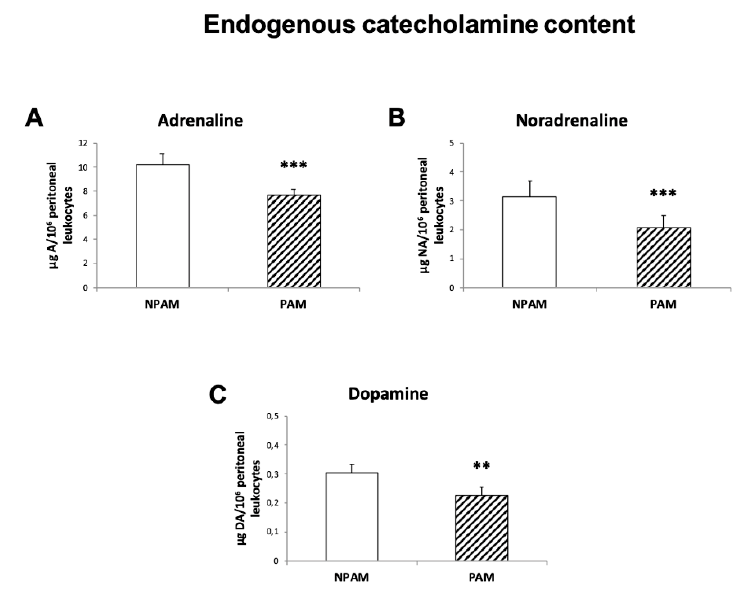
Figure 8. Endogenous catecholamine content ( µ g/10 6 peritoneal leukocytes) analyzed in peritoneal leukocytes from PAM and NPAM. Adrenaline ( A ), Noradrenaline ( B ), and Dopamine ( C ) from adult PAM and NPAM. PAM: prematurely aging mice, NPAM: non-prematurely aging mice. Each column is the mean ± SD of the values of 10 experiments corresponding to 10 animals. ** p < 0.01, *** p < 0.001 with respect to NPAM.